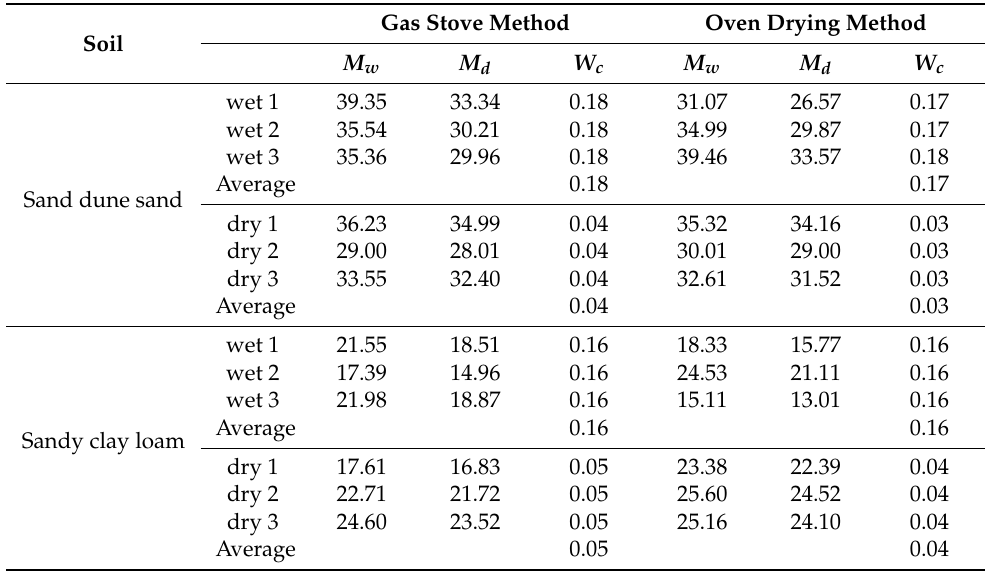
Table A1. Measurement results of gas stove method and oven drying method. M w : mass of moist soil (g); M d : mass of dried soil (g); w c : gravimetric soil water content